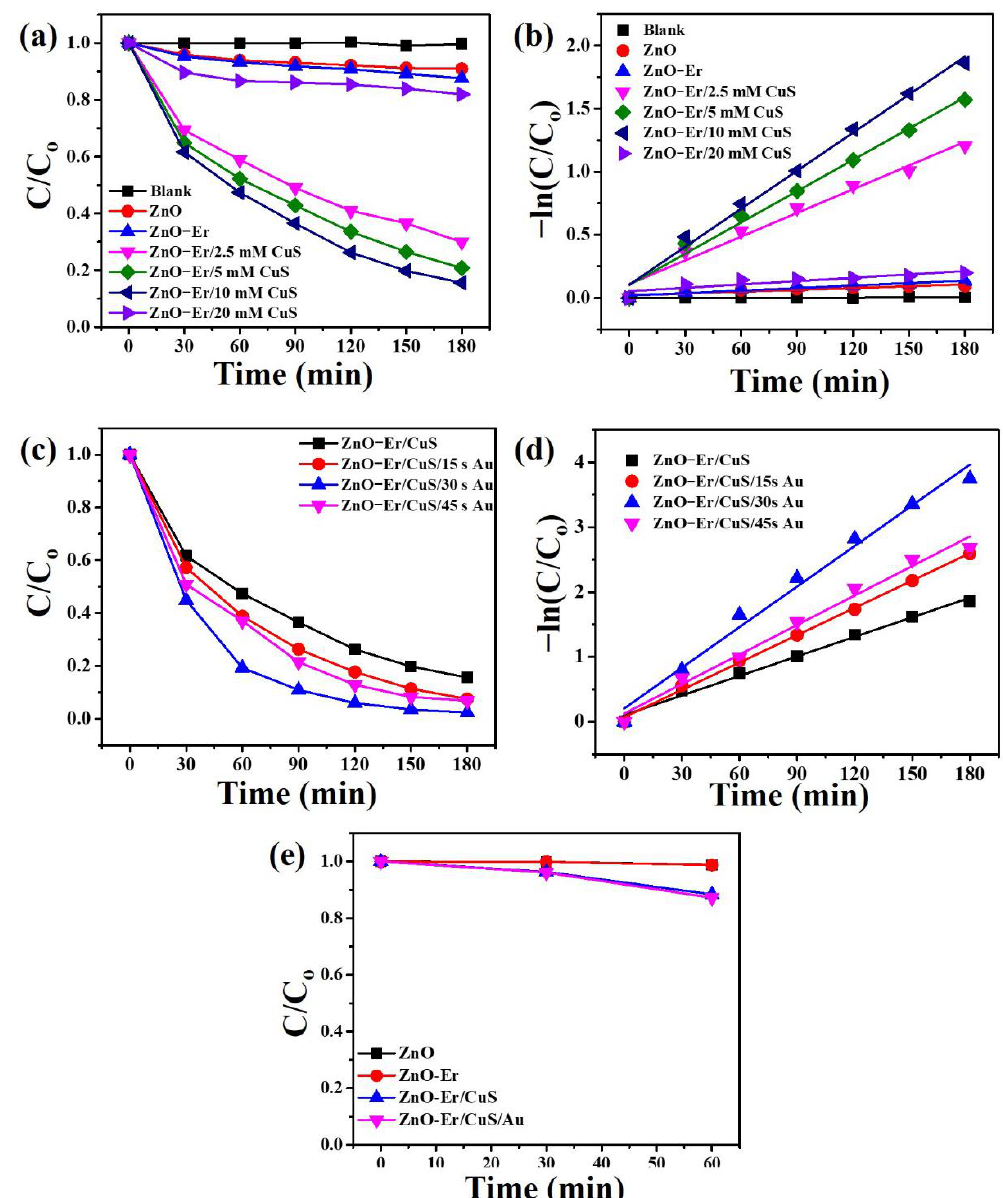
Figure 5. ( a ) Photocatalytic activities and ( b ) kinetic linear simulation curves of ZnO nanowires, Er-doped ZnO nanowires, and Er-doped ZnO/CuS core-shell nanowires with different concentrations of CuS precursor under blue LED light. ( c ) Photocatalytic activities and ( d ) kinetic linear simulation curves of Er-doped ZnO/CuS core-shell nanowires and Er-doped ZnO/CuS/Au core-shell nanowires with different Au-sputtering times under blue LED light. ( e ) The dark absorption spectra of as-prepared photocatalysts.